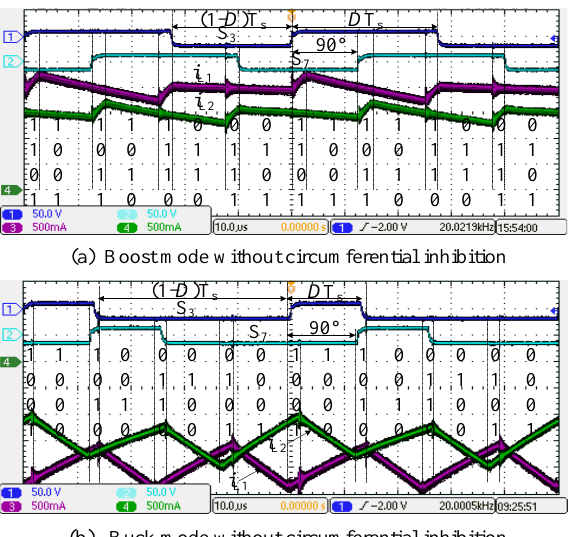
Figure 10. The inductor current ripple is small, and the flying capacitor voltage is equal to 0.25 U H .